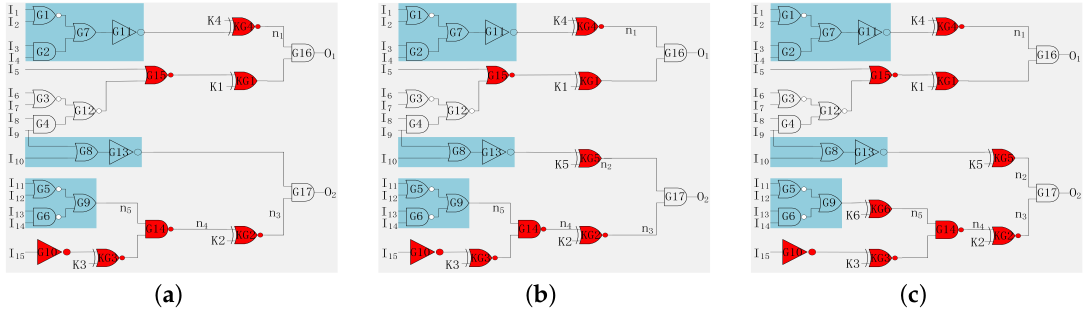
Figure 5. Preventing path sensitization attack. ( a ) Modified (K1) circuit. ( b ) Modified (K2) circuit. ( c ) Modified (K3)